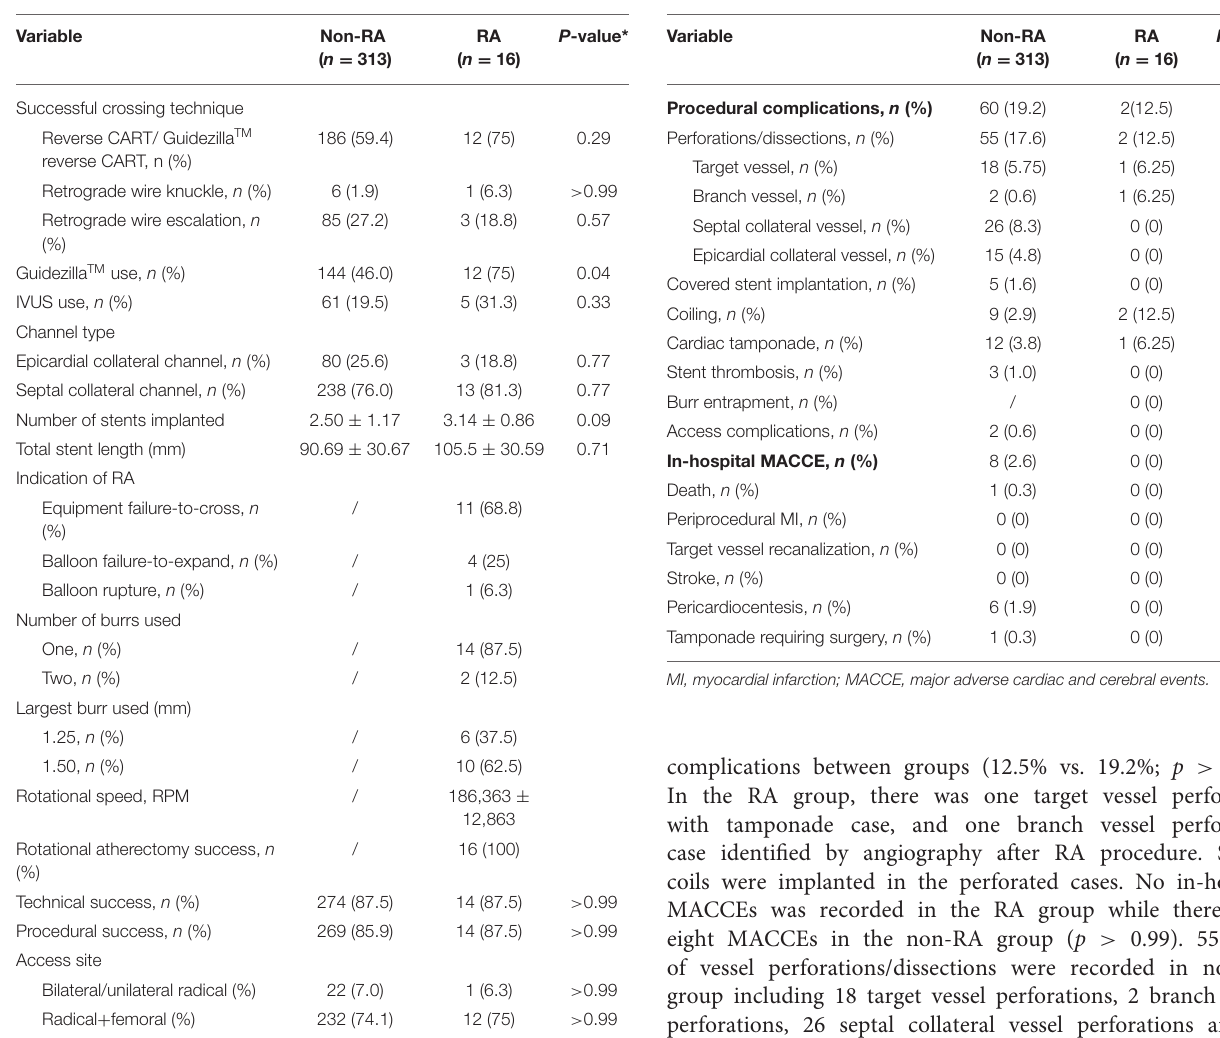
TABLE 3 | Procedural characteristics. TABLE 4 | Procedural complications and in-hospital